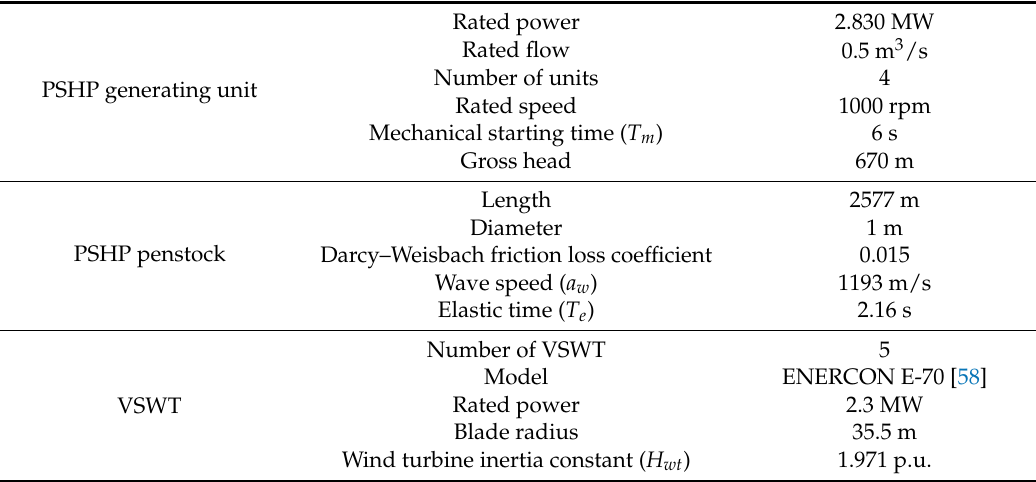
Table 3. Gorona del Viento W-PSHP